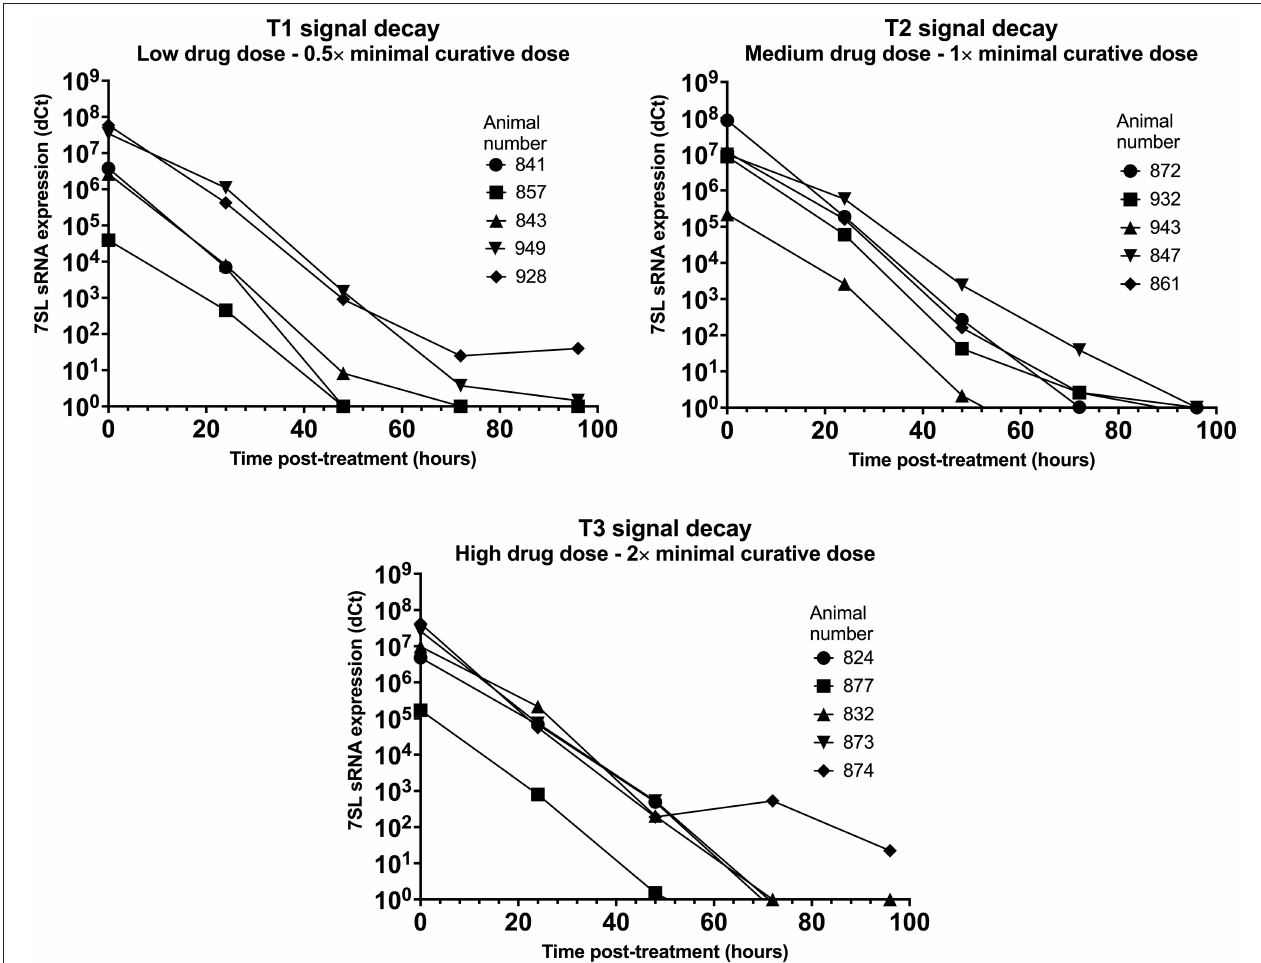
FIGURE 3 | Decay of 7SL sRNA signal in T. congolense infected cattle after trypanocide treatment. Cattle (Holstein-Friesian, n = 5 per treatment group) were infected with T. congolense Kont2/133 (day 0) at peak parasitaemia (1 × 10 4 -5 × 10 5 trypanosomes/ml), cattle were treated with a low (equivalent to 0.5 × minimal effective dose), medium (1 × ) or high dose (2 × ) of an experimental trypanocide. Relative expression of 7SL sRNA by RT-qPCR is shown with a black line and was calculated by normalizing to an uninfected control